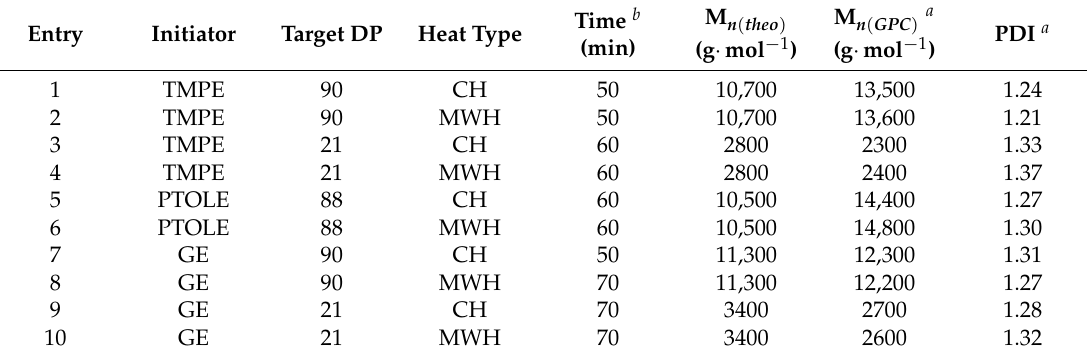
Table 3. Results for TMPE, PTOLE & GE initiated ROP to Synthesis Amphiphilic Core Corona Stars